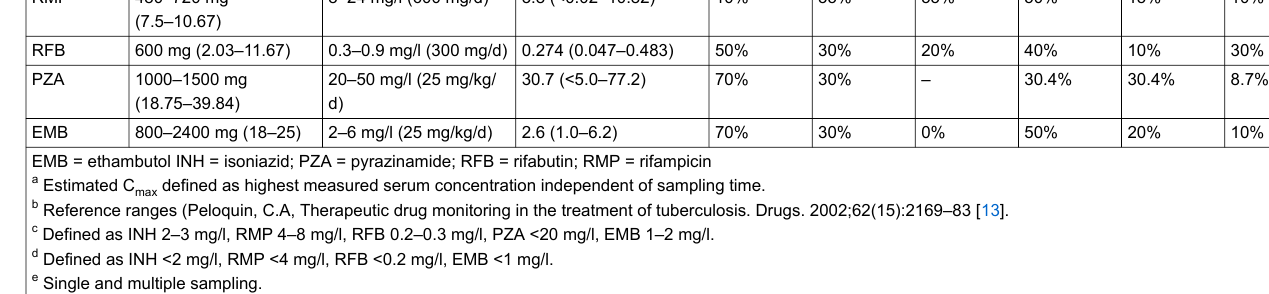
e Single and multiple